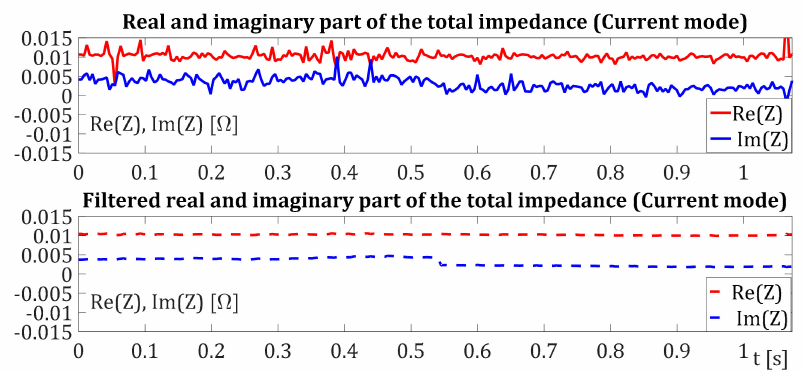
Figure 14. Experimental results for the real and imaginary part of the total impedance during current test signals.